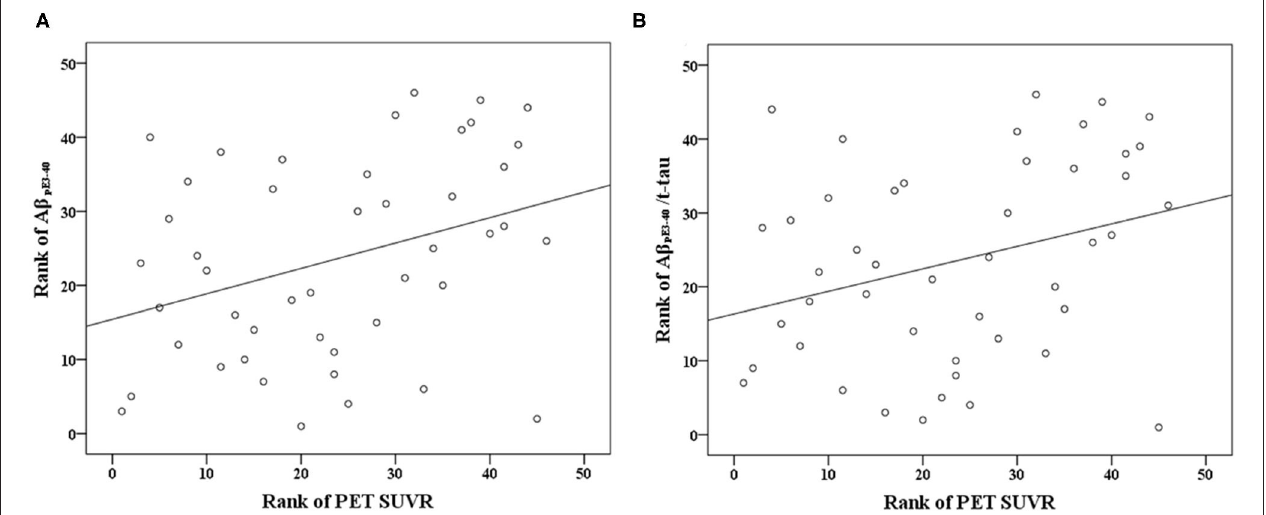
FIGURE 1 | Scatterplots of the associations between A β PET SUVR and plasma biomarker levels (pg/mL) of (A) A β pE3 − 40 and (B) A β pE3 − 40 /t-tau.